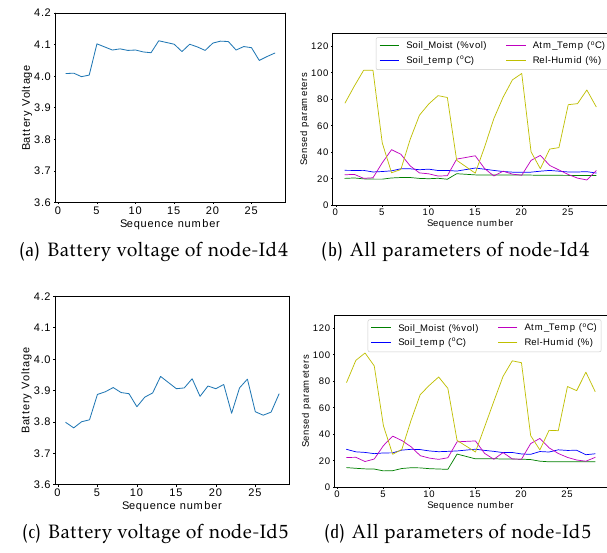
Figure 32. Sensed parameters - data collection round 2, test case 3. Time interval between two consecutive sequence